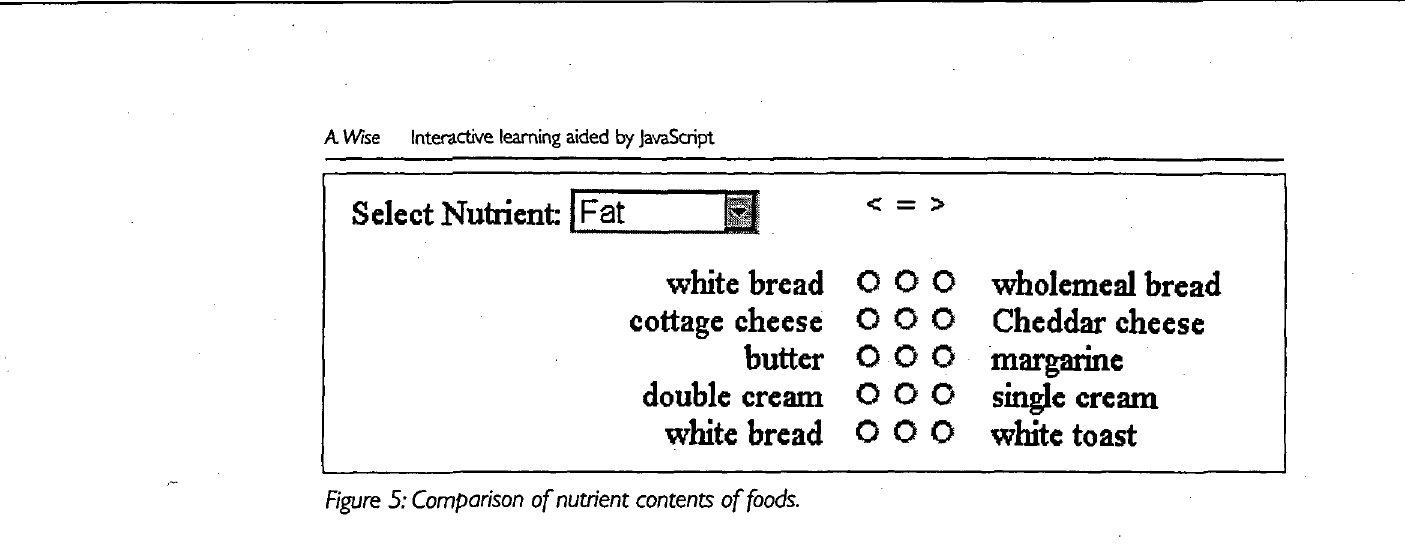
figure 5: Comparison of nutrient contents of